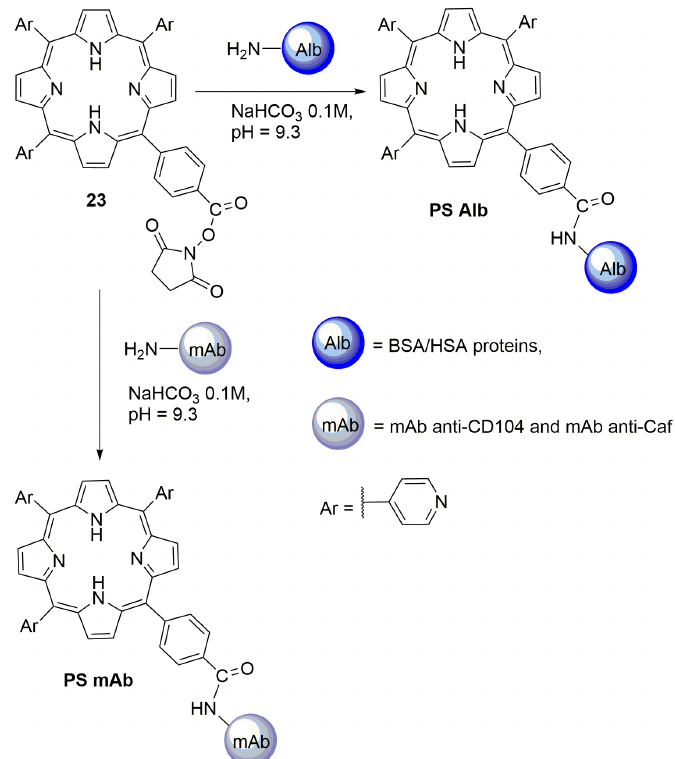
Figure 21 - Synthetic approach to porphyrin conjugates with serum albumins PS Alb (BSA and HAS proteins) and monoclonal antibodies PS mAb (anti-CD104 and anti-Caf).